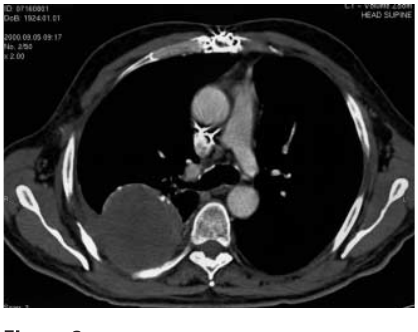
Figure 2 Axial post-contrast CT image showing the pleu- ral mass in the right dorsal upper hemithorax. Note the coarse calcifications lining the vis- ceral pleura. The slightly irregular anterior surface of the rib was interpreted as a sign of chest wall involvement.